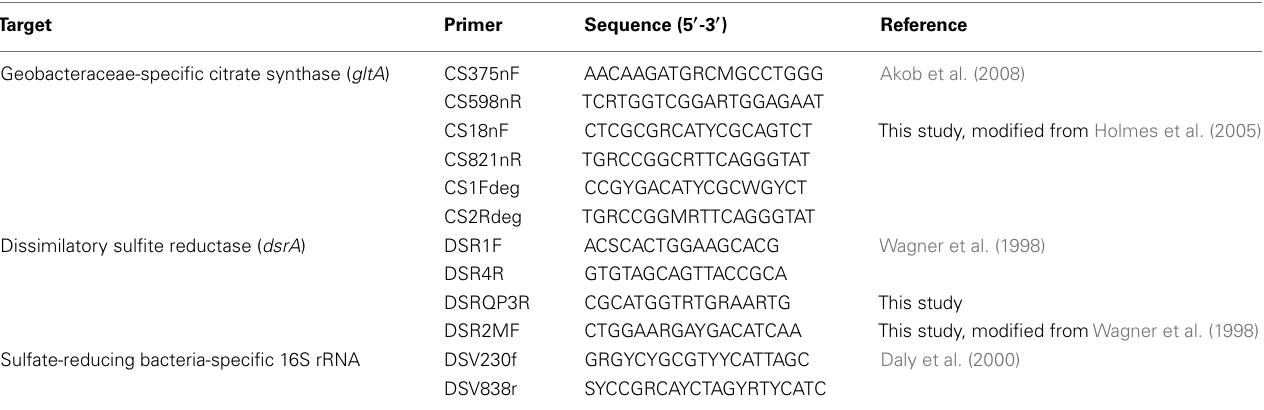
Table 1 | Primers used in this